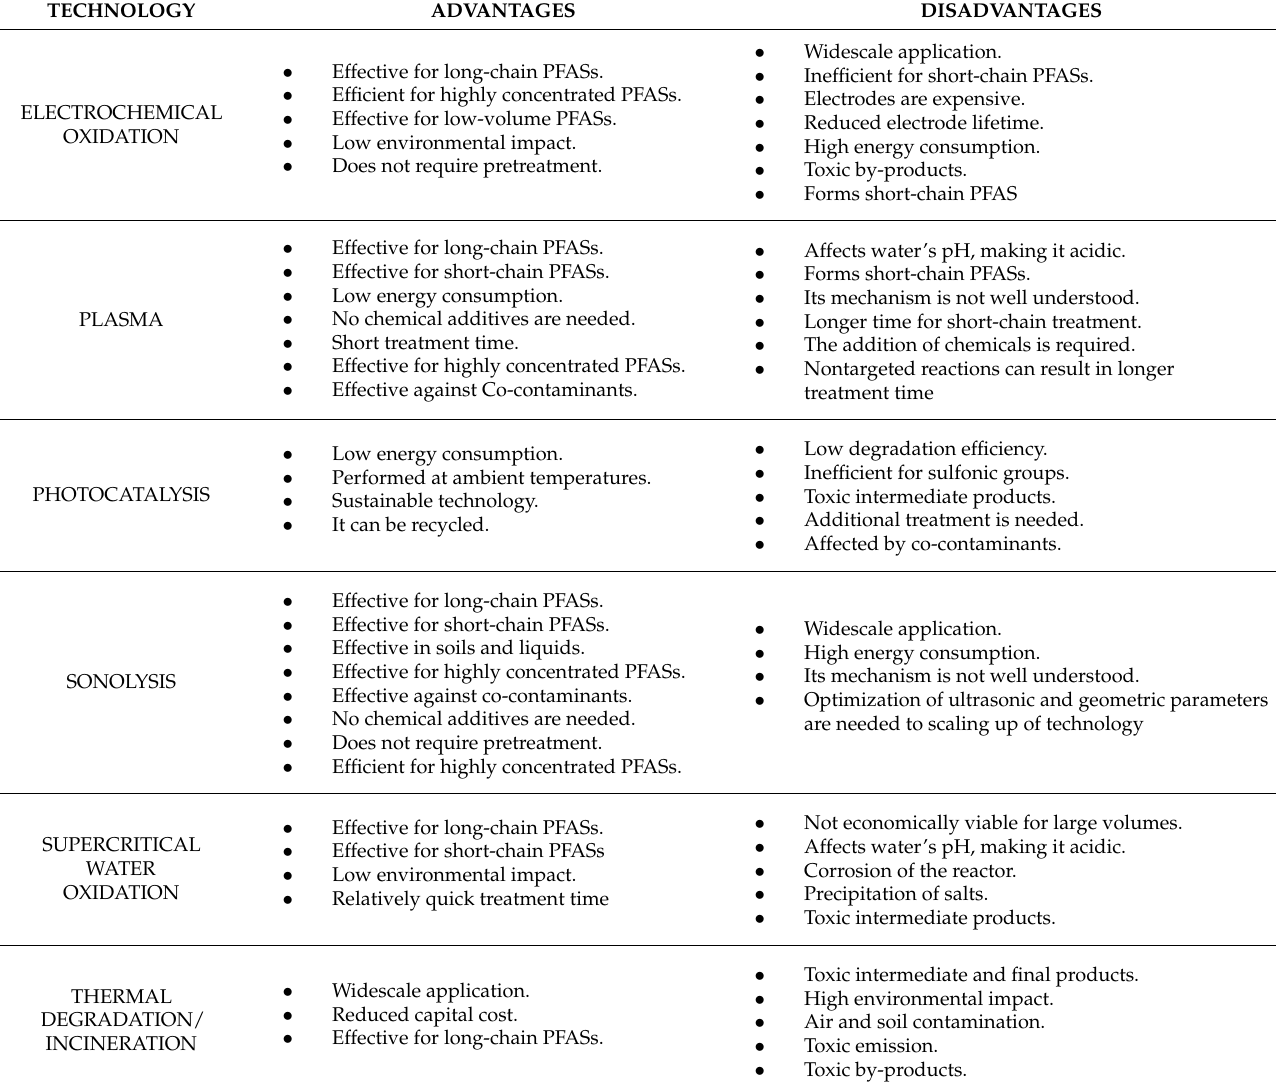
Table 2. Summary of the main advantages and disadvantages of the PFAS destructive